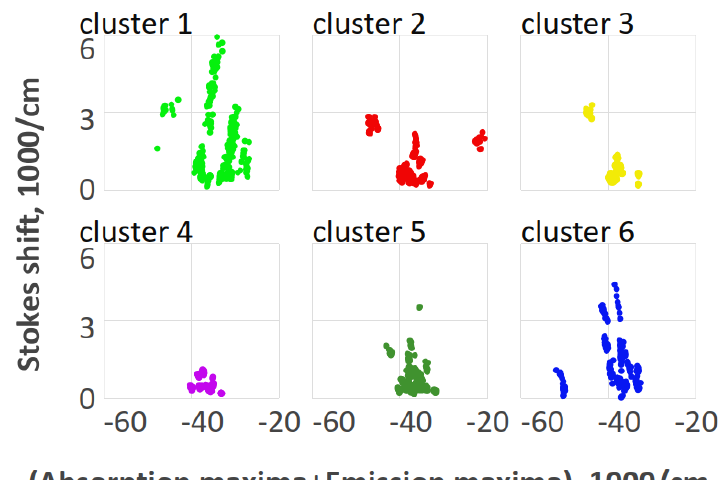
Figure 5. Stokes shift vs − (Absorption maxima + Emission maxima) diagram in terms of 1000/cm for a 6-cluster dataset of 115 BODIPYs. For the key for the clusters, see Schemes 1–6 and Figure 3. The frequency diagram shown in Figure 6 demonstrates a high quantum yield for a large number of dyes bearing near-zero solvatochromism (clusters 4 and 5), indicating the role of the dye polarity in the quantum yield. The plot of toe quantum yield vs Stokes shift, shown in Figure 7, is convenient for practical use.